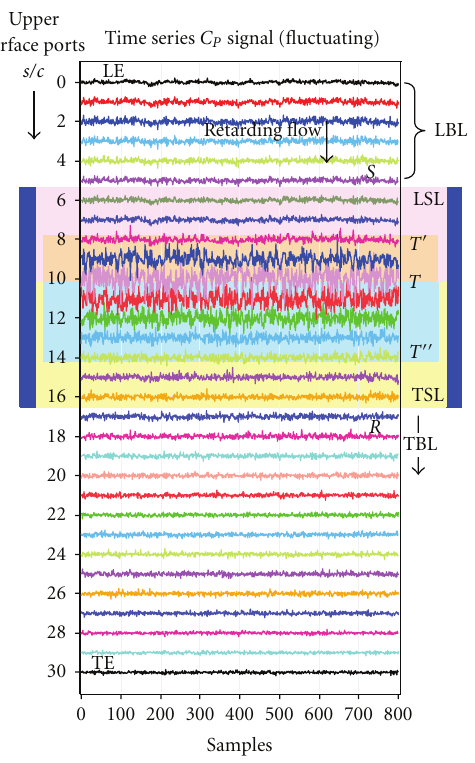
Figure 6: Time series C P signals (fluctuating) at Re = 0 . 2 E 06 and α = 9 . 5 ◦ .